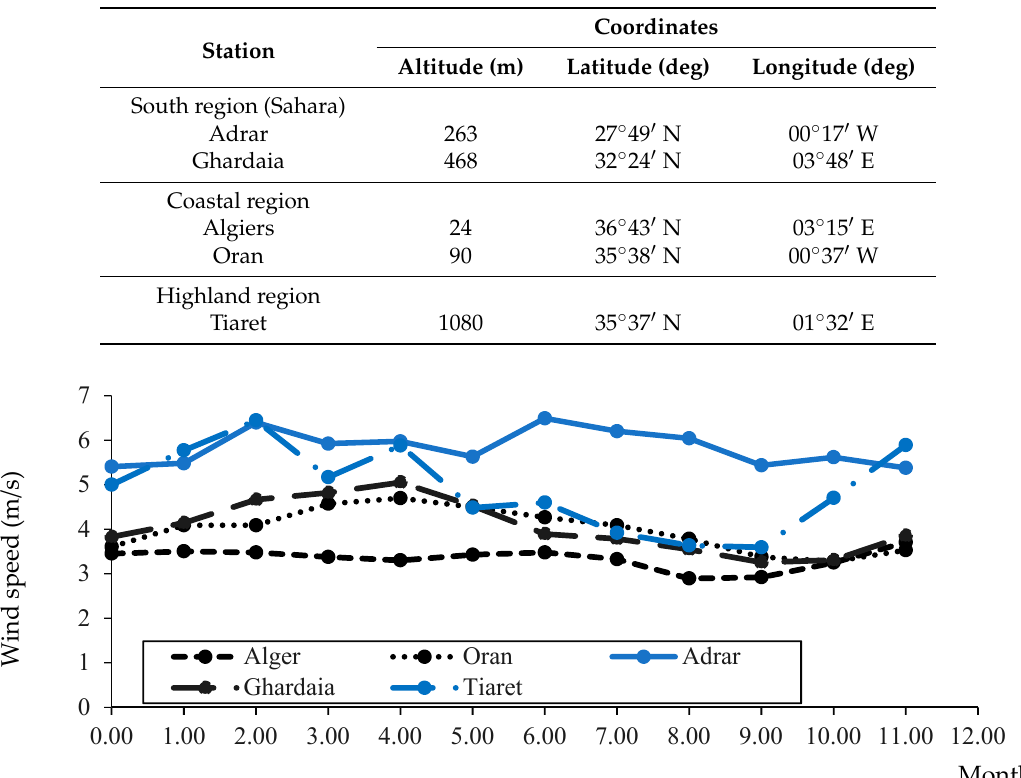
Table 1. Coordinates of stations at different Algerian sites.